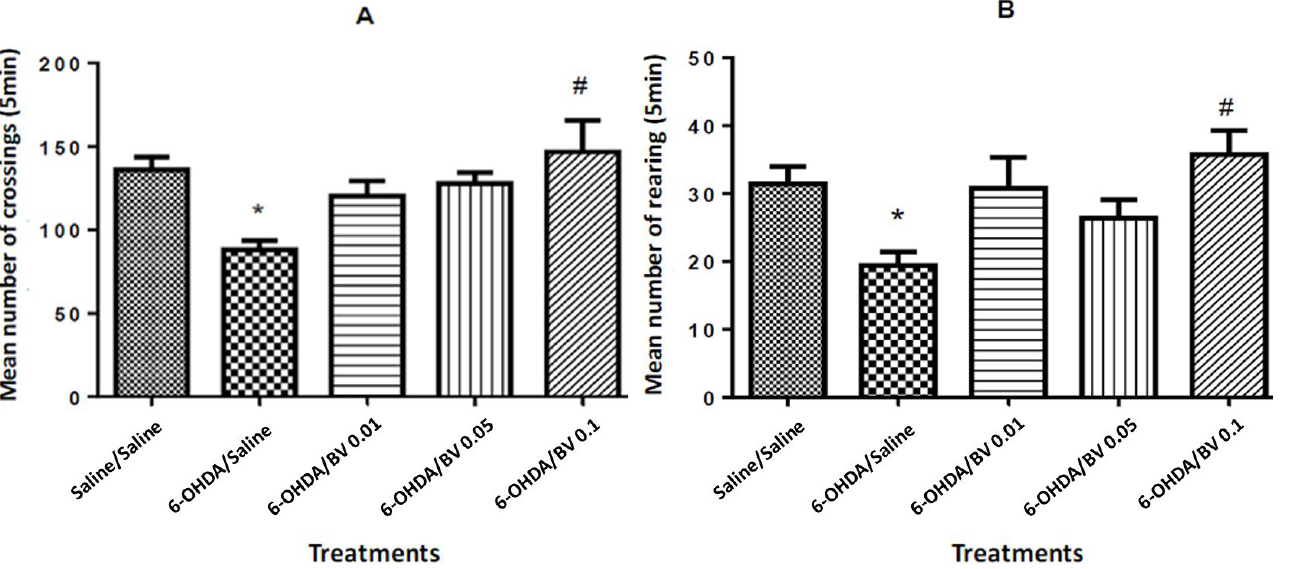
Figure 2. The open field test: effects of the bee venom—BV—(0.01; 0.05 and 0.1 mg·Kg −1 ) on crossing ( A ) and rearing ( B ) behaviors. Bars represent the mean (± SEM) of behaviors expressed in 5 minutes. * indicates significant difference from saline/saline ( p < 0.05), and # ( p = 0.001) indicates significant difference from 6-OHDA/ saline. One-way ANOVA followed by Tukey's post test.